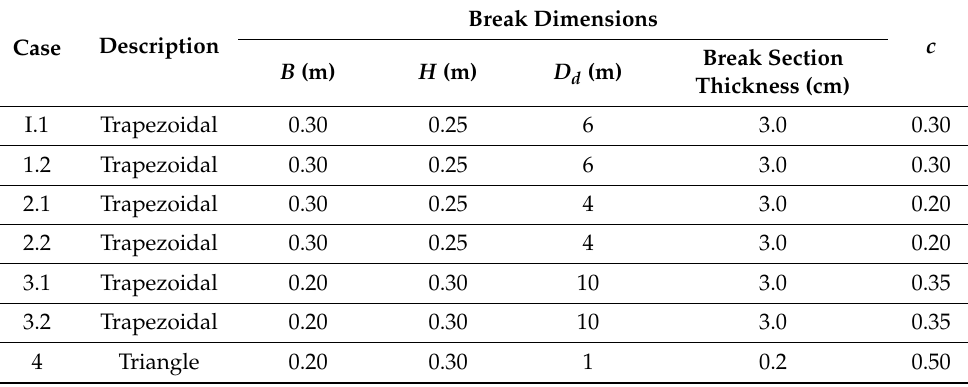
Table 1. Dam-break experiment data and